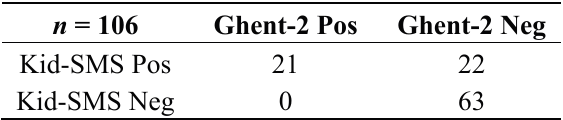
Figure 1. Age at first presentation to Marfan clinic. Table 3. Fourfold table of risk stratification with Kid-SMS and diagnosis with Ghent-2 at baseline (first presentation). (Ghent-2 Pos, revised Ghent Criteria positive; Ghent-2 Neg, revised Ghent Criteria negative; Kid-SMS Pos, Kid-Short Marfan Score positive; Kid-SMS Neg, Kid-Short Marfan Score negative).